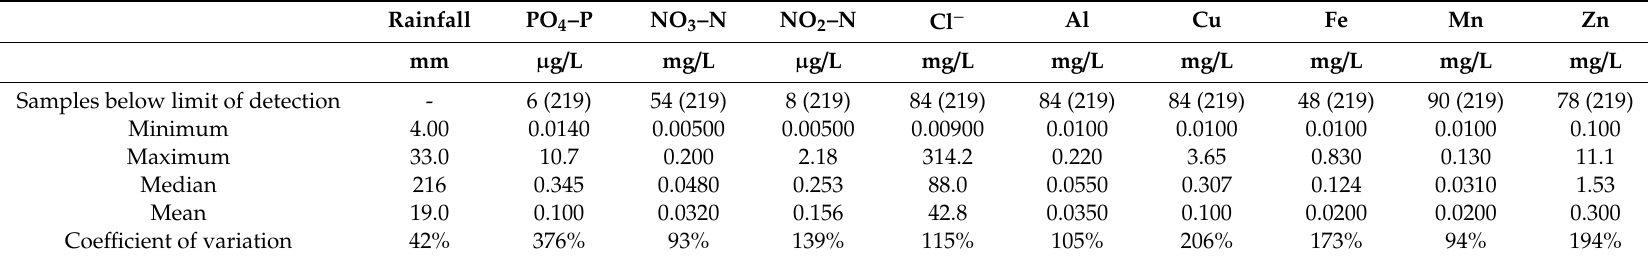
Table 1. Summary for dissolved nutrient and metal concentrations measured in infiltrated water in roadside ditches on I-29 near Trent, South Dakota, United States. Numbers in parentheses represent the total samples collected. Water samples were collected for major rainfall events between May 2016 and October 2017.